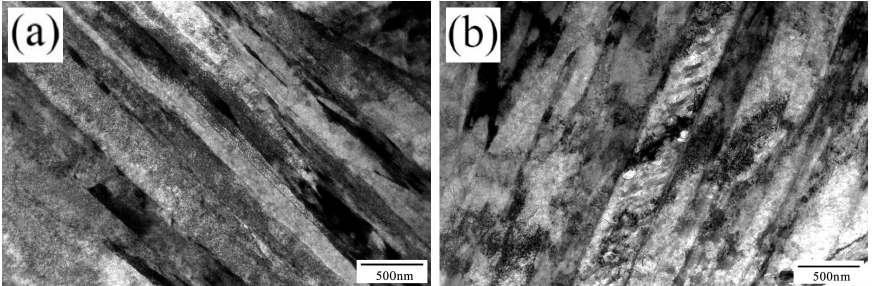
Figure 14. TEM micrographs of lath martensite of two investigated steels after heating for 5 min. ( a ) 22Mn3SiNb, 800 °C, ( b ) 22MnB5, 950 °C.